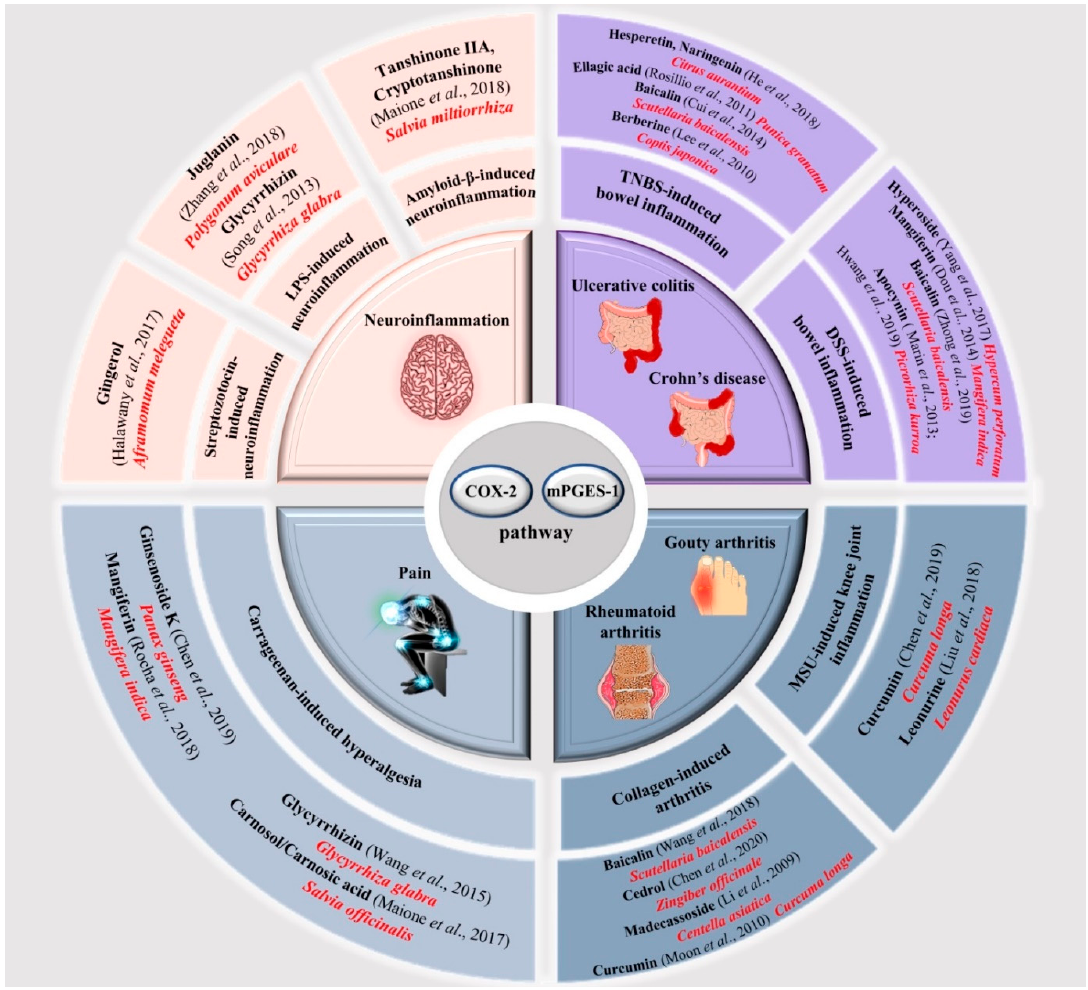
Figure 1. Schematic representation of natural compounds (black bold), by different botanical sources (in red) targeting COX-2/mPGES-1 pathway as alternative therapies for different inflammatory-related diseases. The figure, also, shows the pre-clinical models (black bold), where these active components have been tested with related bibliographic references.